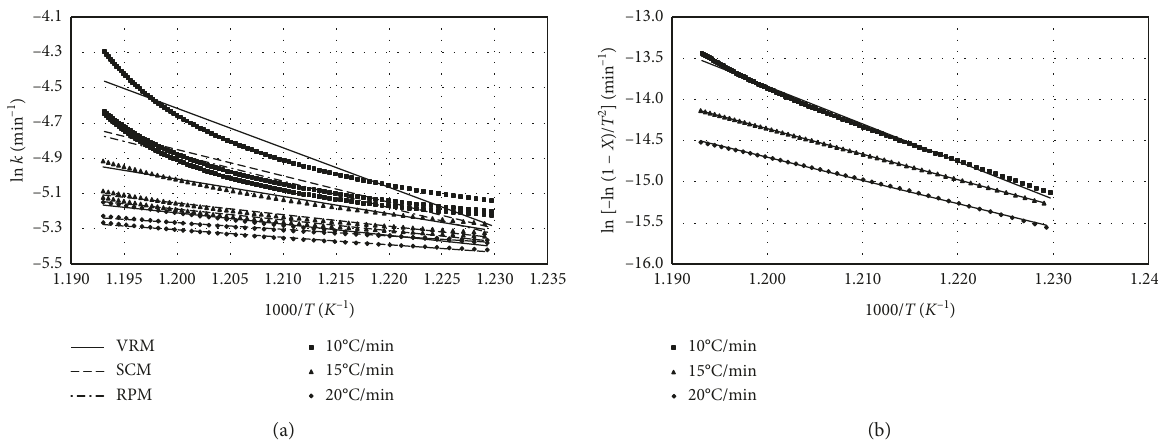
Figure 3: Comparison of Arrhenius plots for different heating rates of 10, 15, and 20 ° C/min vs. (a) VR, SC, and RP models; (b) CR model. Table 5: Activation energy of petcoke. Activation energy (kJ/mol) Heating rate ( ° C/min)